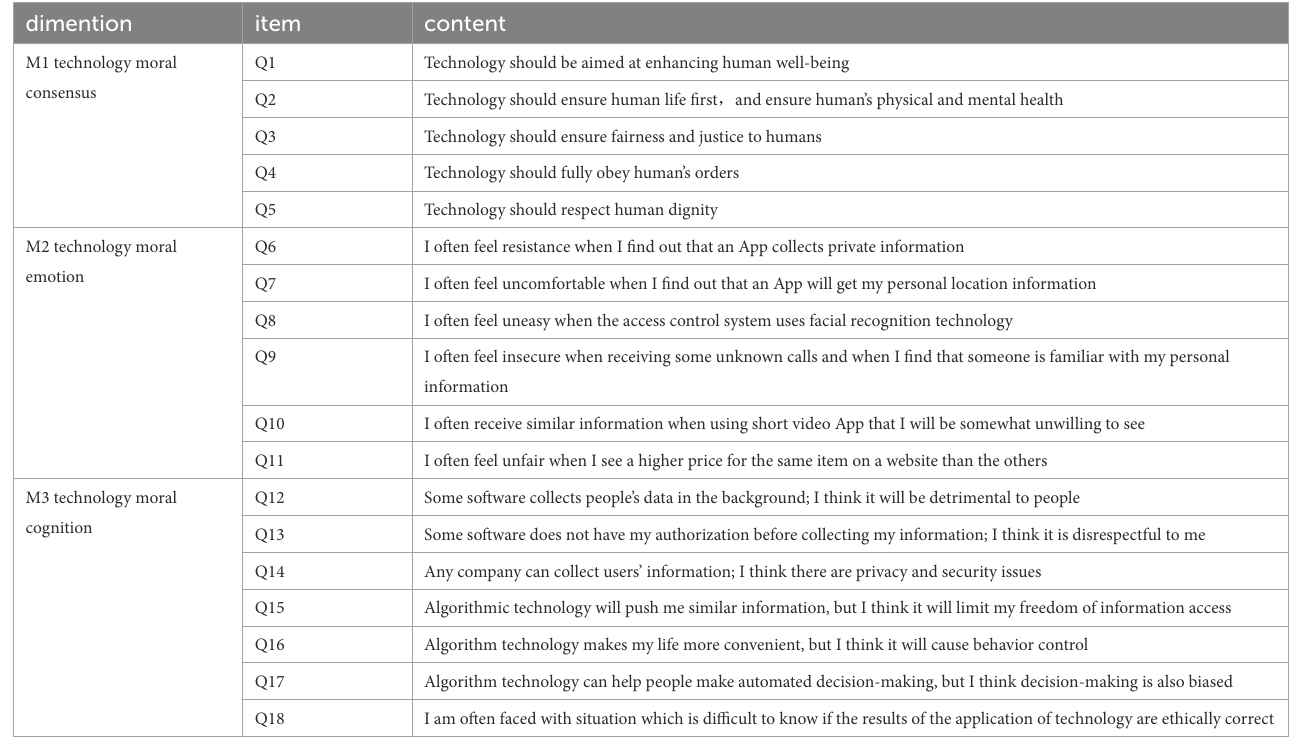
TABLE 4 Technology moral sense